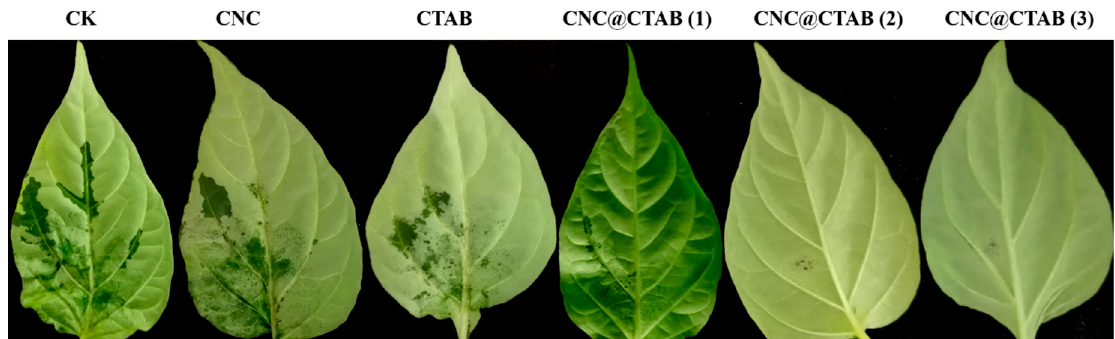
Figure 4. In vitro test of pepper leaves. CNC@CTAB, CTAB, CNC inhibit the infection of pepper leaves by Phytophthora capsici . CNC@CTAB (3) means that the CTAB density on the CNC surface is 5.50 × 10 − 2 nmol / cm 2 . CNC@CTAB (2) means that the CTAB density on the CNC surface is 3.96 × 10 − 2 nmol / cm 2 . CNC@CTAB (1) means that the CTAB density on the CNC surface is 2.86 × 10 − 2 nmol / cm 2 . CNC is the cellulose nanocrystal. CTAB is the hexadecyltrimethylammonium bromide. CK is the water group. Table 2. Disease index of the pepper leaves in each treatment group.